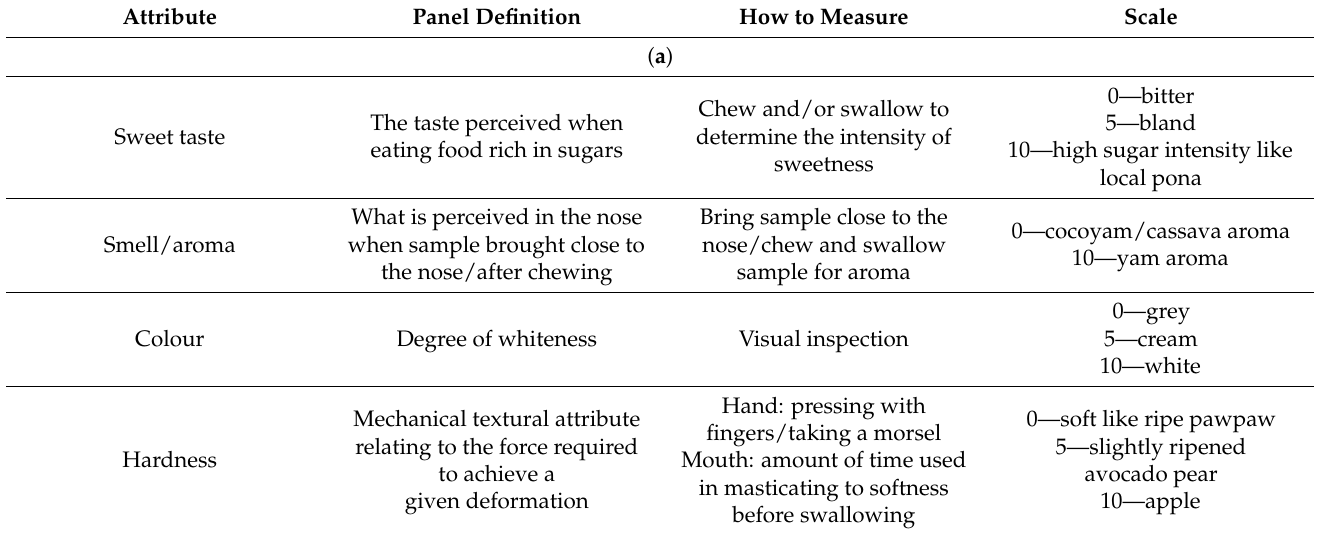
Table 1. ( a ) Attributes generated by trained sensory panellists for boiled yam; ( b ) attributes generated by trained panellists for pounded